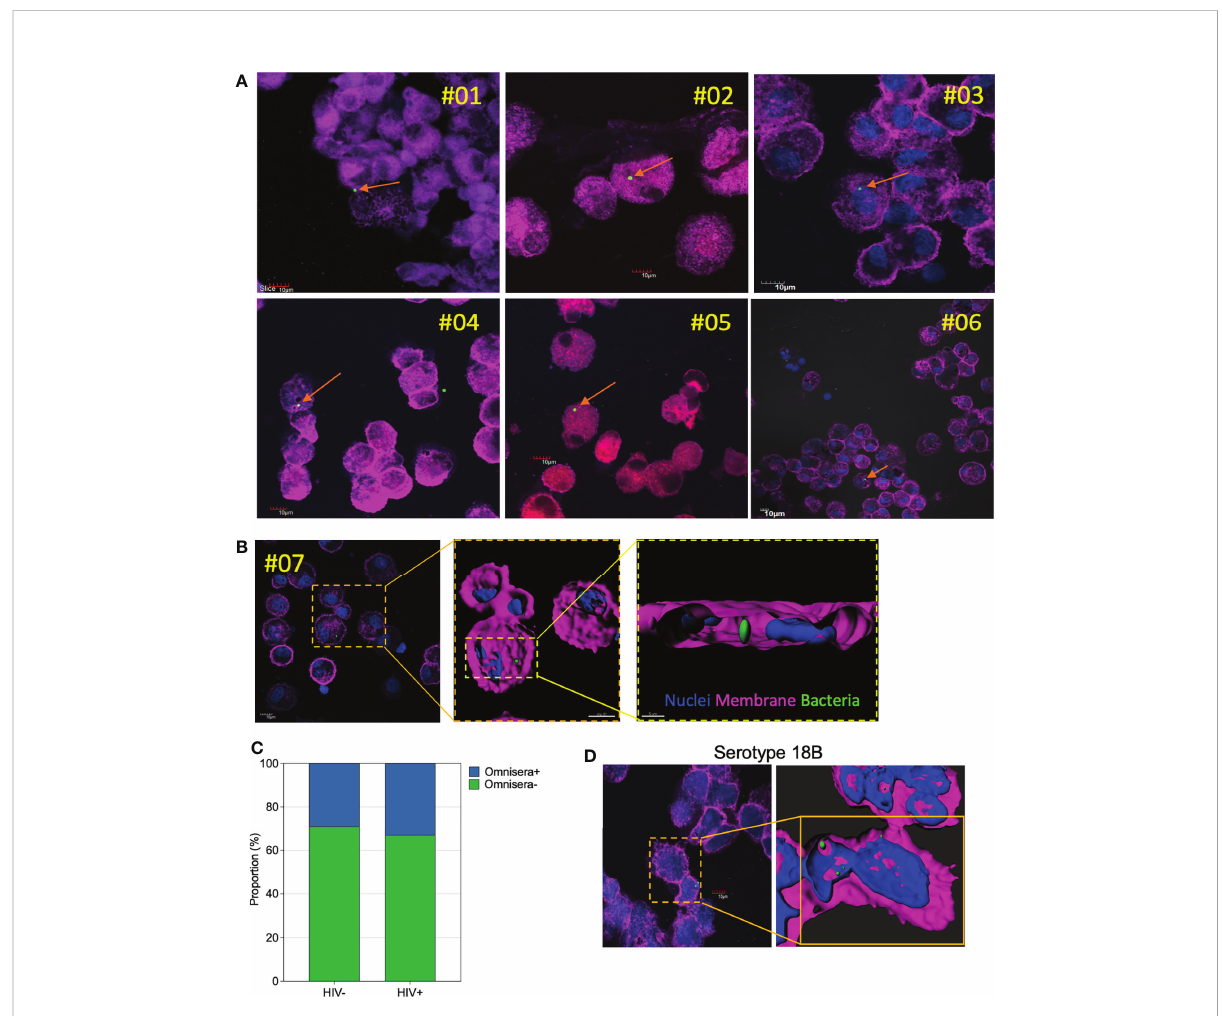
FIGURE 4 In vivo survival and detection of pneumococci within AMs. Representative single confocal microscopy images taken from a subset of individuals showing presence of pneumococci within cells analogous to AMs. (A) A subset of 6 individuals showing in vivo internalized pneumococci (arrow) within AMs. (B) Representative single confocal microscopy image showing internalized pneumococci (dashed lines) within AMs. Three- dimensional reconstruction through deconvolution analysis shows the localization of the pneumococci within the AMs from the upper focal plane. The same three-dimensional reconstruction clari fi es the localization of the pneumococci within the AMs. (C) Proportion of AMs testing positive for pneumococcal omnisera (HIV-uninfected, n=18; treated HIV+, n=31). (D) A representative confocal image showing AMs positivity for serotype 18B, also identi fi ed in the nasal swabs. The three-dimensional reconstruction image of the pneumococci serotype 18 within the AMs. WGA; cell membranes – purple; DAPI – nucleus; with pneumococci-ST3 (bacteria – green) at magni fi cation x63. Scale bars for panel A, all 10 m m; panel B, top right and left =10 m m, bottom right =5 m m; panel D, left panel=10 m m and right panel=5 m